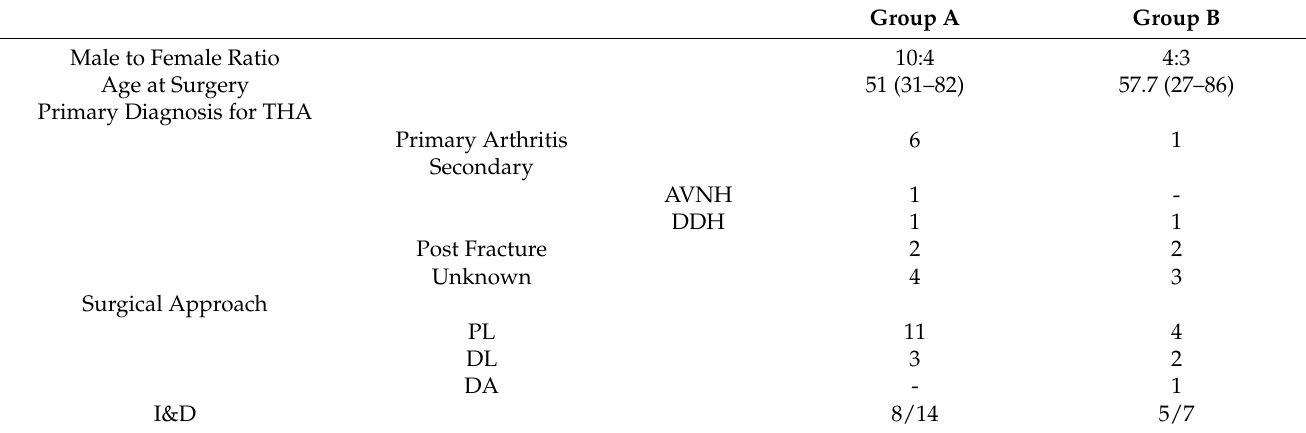
Table 1. Patients’